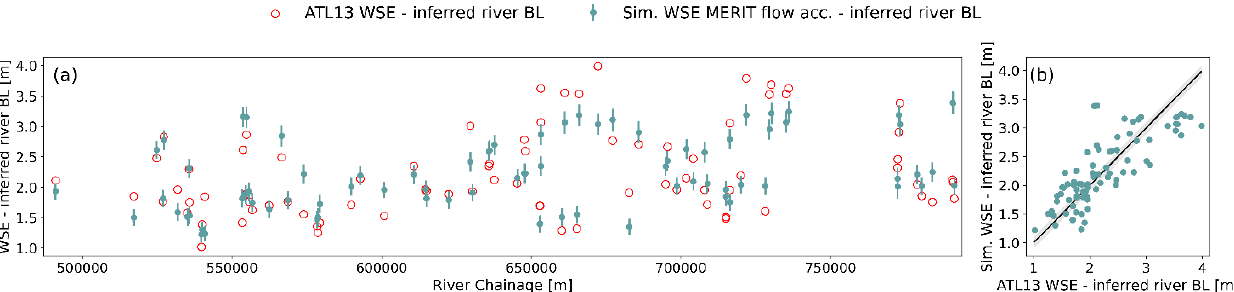
Figure 8. (a) Calibrated longitudinal profile using the steady-state solver for uniform depth and the MERIT flow accumulation between Jimai and Mentang. (b) Simulated vs. ATL13 WSE minus inferred BL. The shaded area corresponds to the mean standard deviation in the ATL13 product, as extracted from the flag stdev_water_surf.